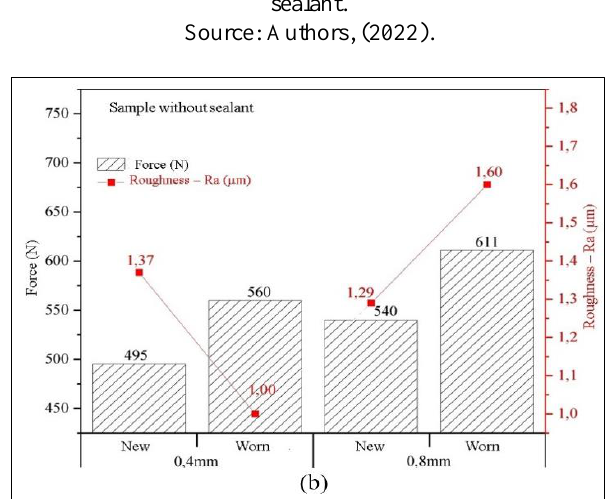
Figure 11b: Machining force x surface finish: b) Samples without